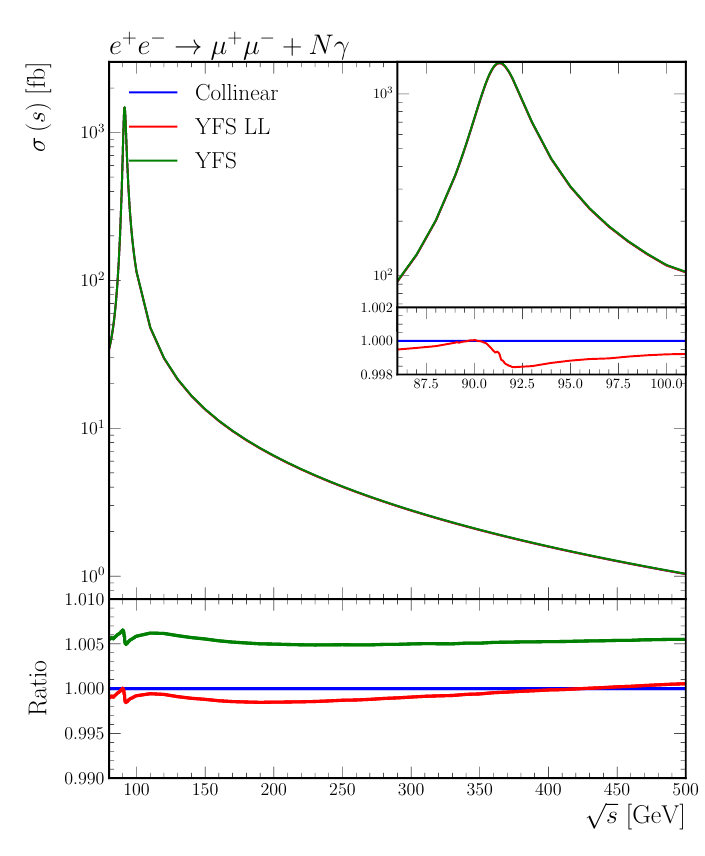
Figure 7: Total cross-section for e + e − → µ + µ − for 80GeV to 500GeV where the ISR is modelled using a collinear (blue) resummation and compared against the soft (cid:0) α 3 (cid:1) L 3 resummation up to . The red line represents the strictly leading logarithmic O YFS resummation while the green represents the full YFS